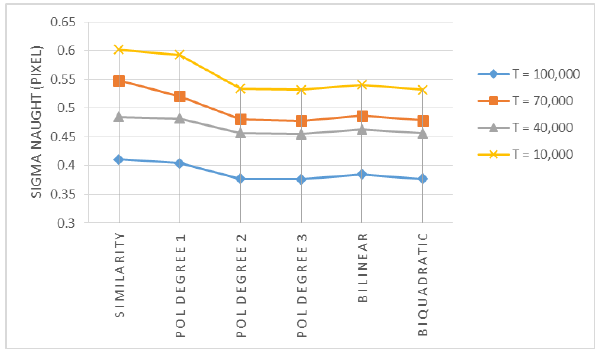
Figure 3. Multi-image registration results using different mapping functions and thresholds for blob calculation. Image ID #5 was assumed as reference